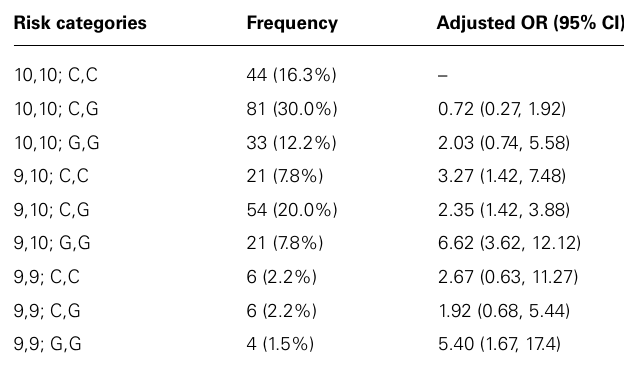
Table 3 | Results from a multiple logistic main effects regression model predicting